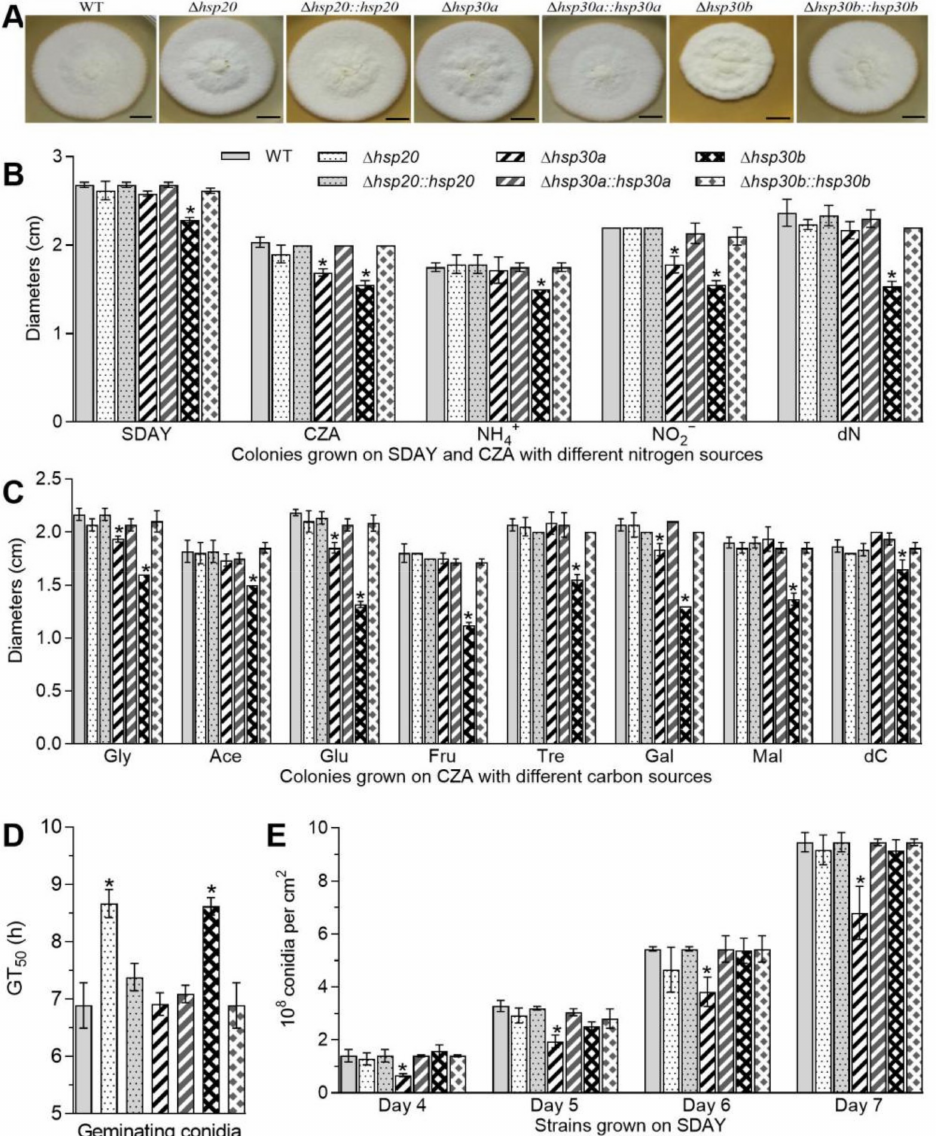
Figure 2. Differential roles of hsp20 , hsp30a , and hsp30b in the asexual cycle of B. bassaiana . ( A ) Images of fungal colonies after 8-day growth on SDAY plates at 25 ◦ C. ( B , C ) Diameters of fungal colonies after 8 days of cultivation at 25 ◦ C on SDAY, CZA and modified CZA media with different carbon/nitrogen sources. ( D ) GT 50 s on germination medium (GM) plates. ( E ) Conidial yields during the period of incubation. Asterisked bars in each bar group differ significantly from those unmarked (Tukey’s HSD, p < 0.05). Error bars: SD from three